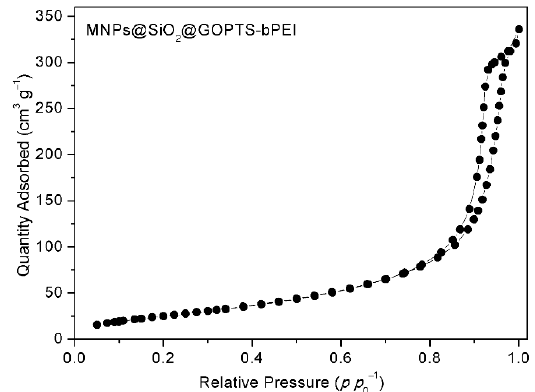
Figure 2 . Graph of N 2 adsorption and desorption isotherm (77 K) as a function of relative pressure of